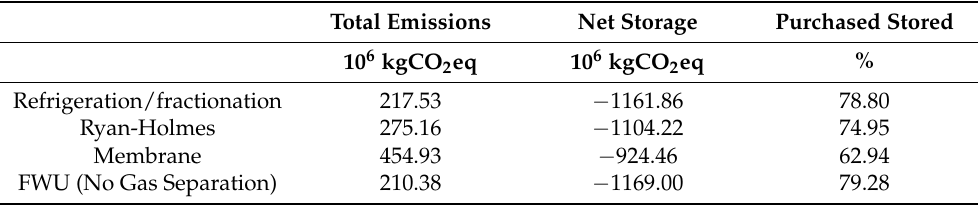
Table 7. Total Emission and Net Storage for cases